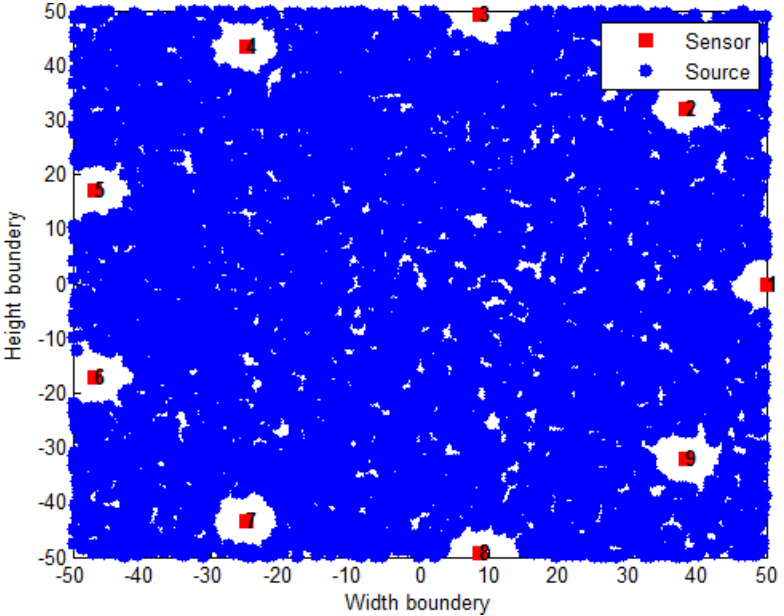
Figure 7. Random Distribution of 10,000 sources for N = 9.